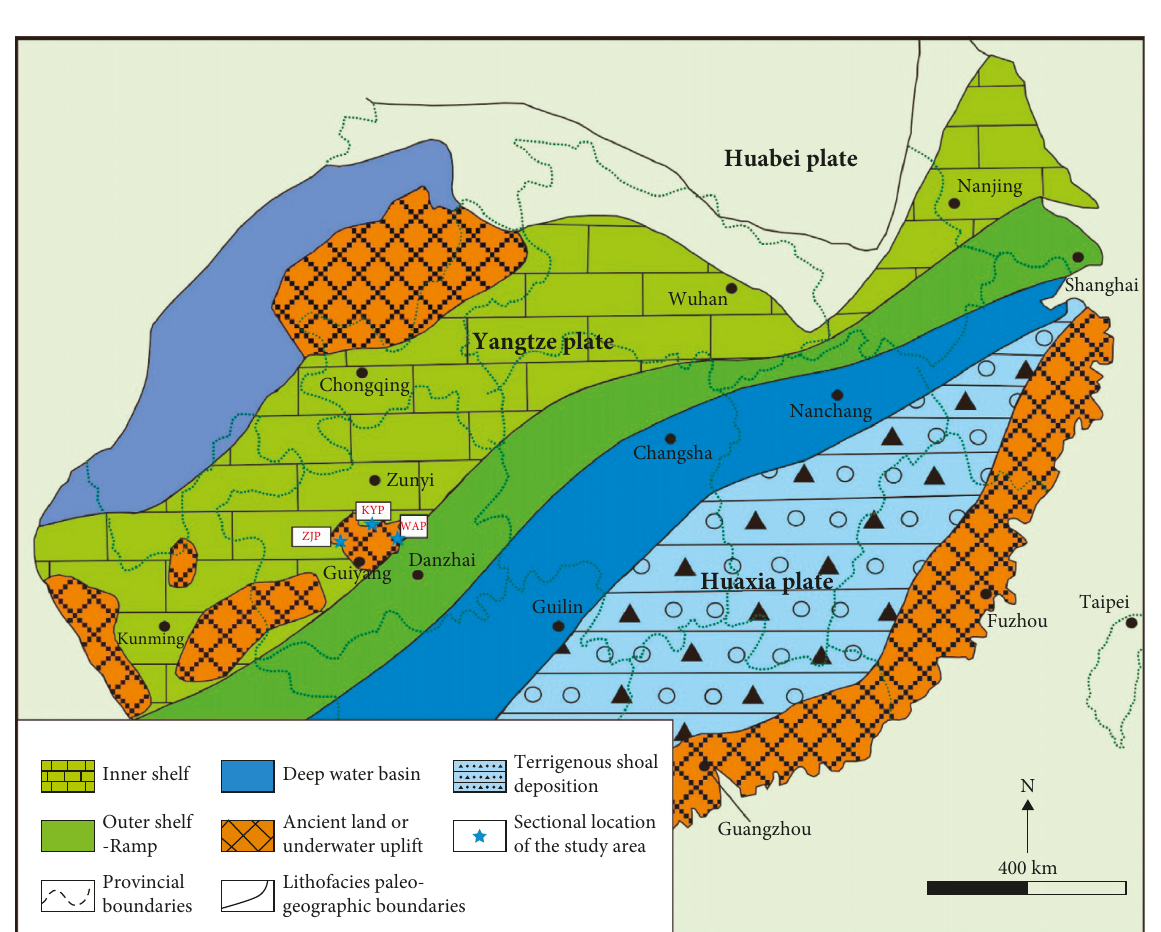
Figure 1: Palaeogeographic map of the Yangtze platform during the depositional period of the Sinian Doushantuo formation (Ref. [28],